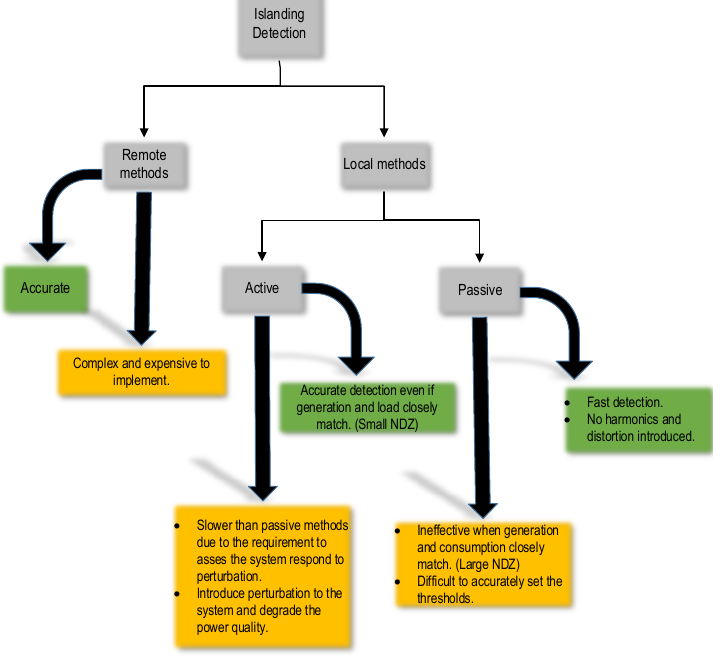
Figure 4. Islanding detection methods.